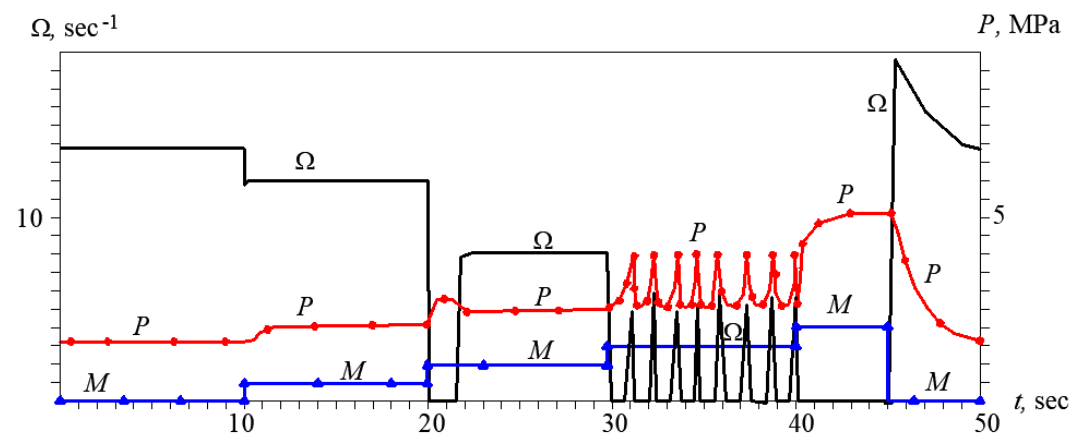
Fig. 3. Calculation oscillogram of the work of the volumetric hydraulic motor with the length of the force line 1500